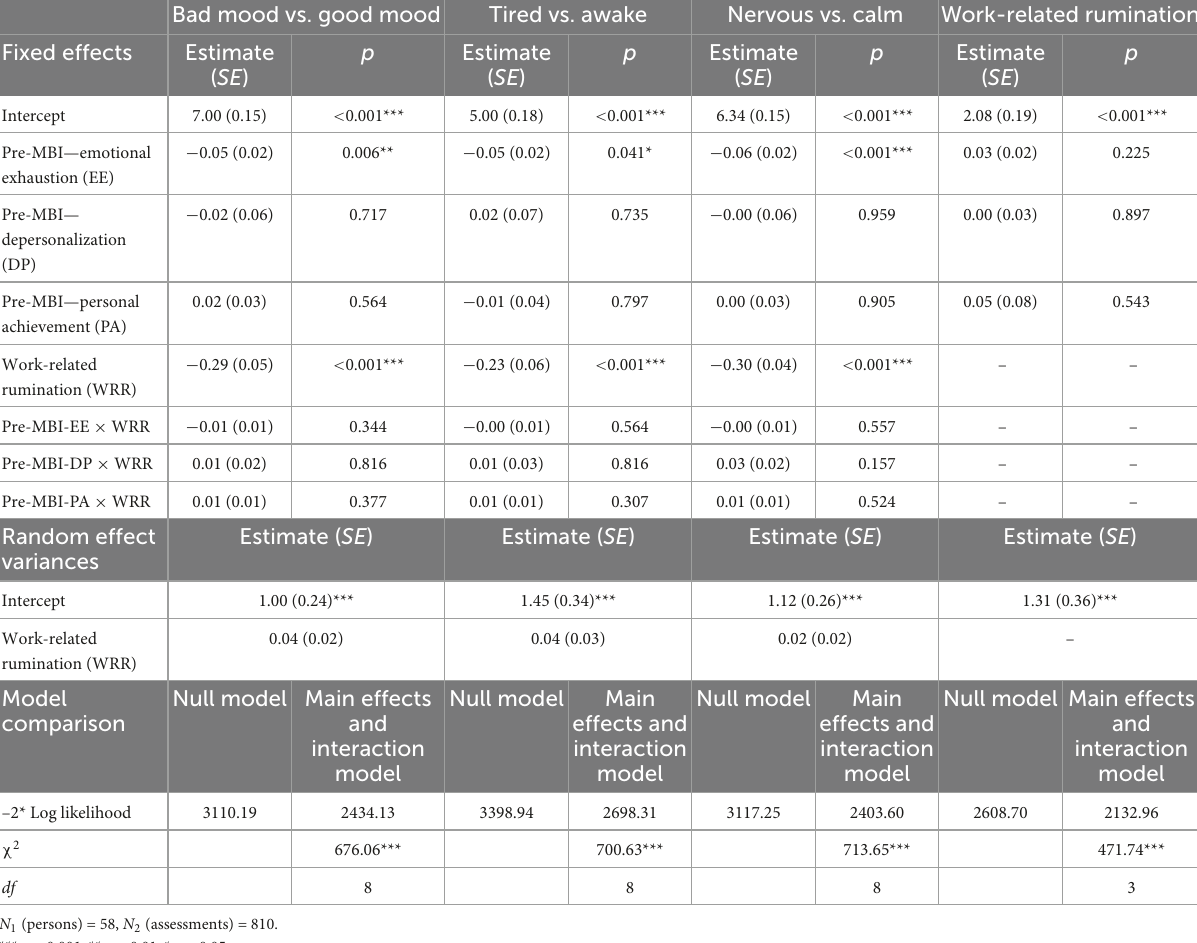
TABLE 4 Multilevel models predicting daily level-1 variables for work-related rumination and the MDMQ scales. Bad mood vs. good mood Tired vs.